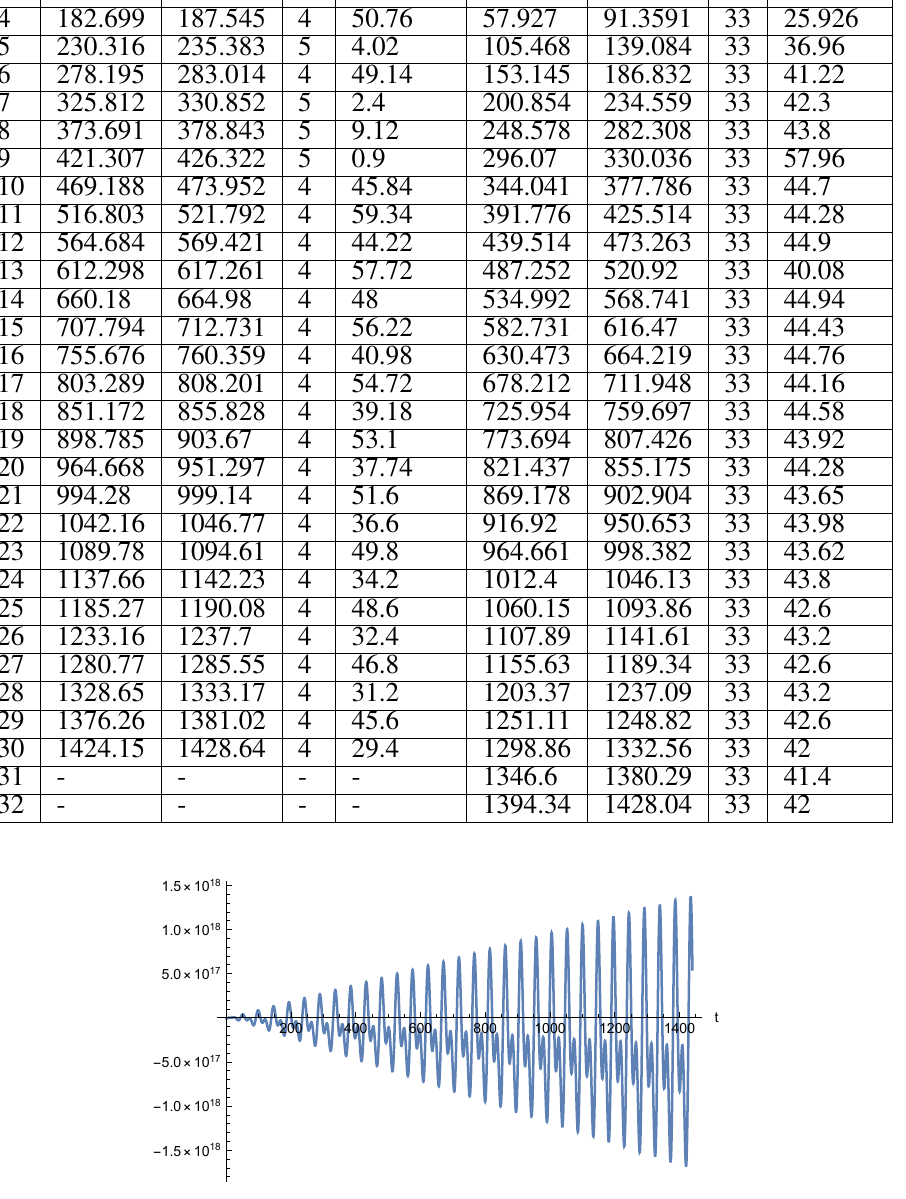
Fig. 5 Visibility Intervals Between HST and ODIN For 24-H with Oblateness Force observed that the time of periods of the visibility increases and decreases in an oscillating